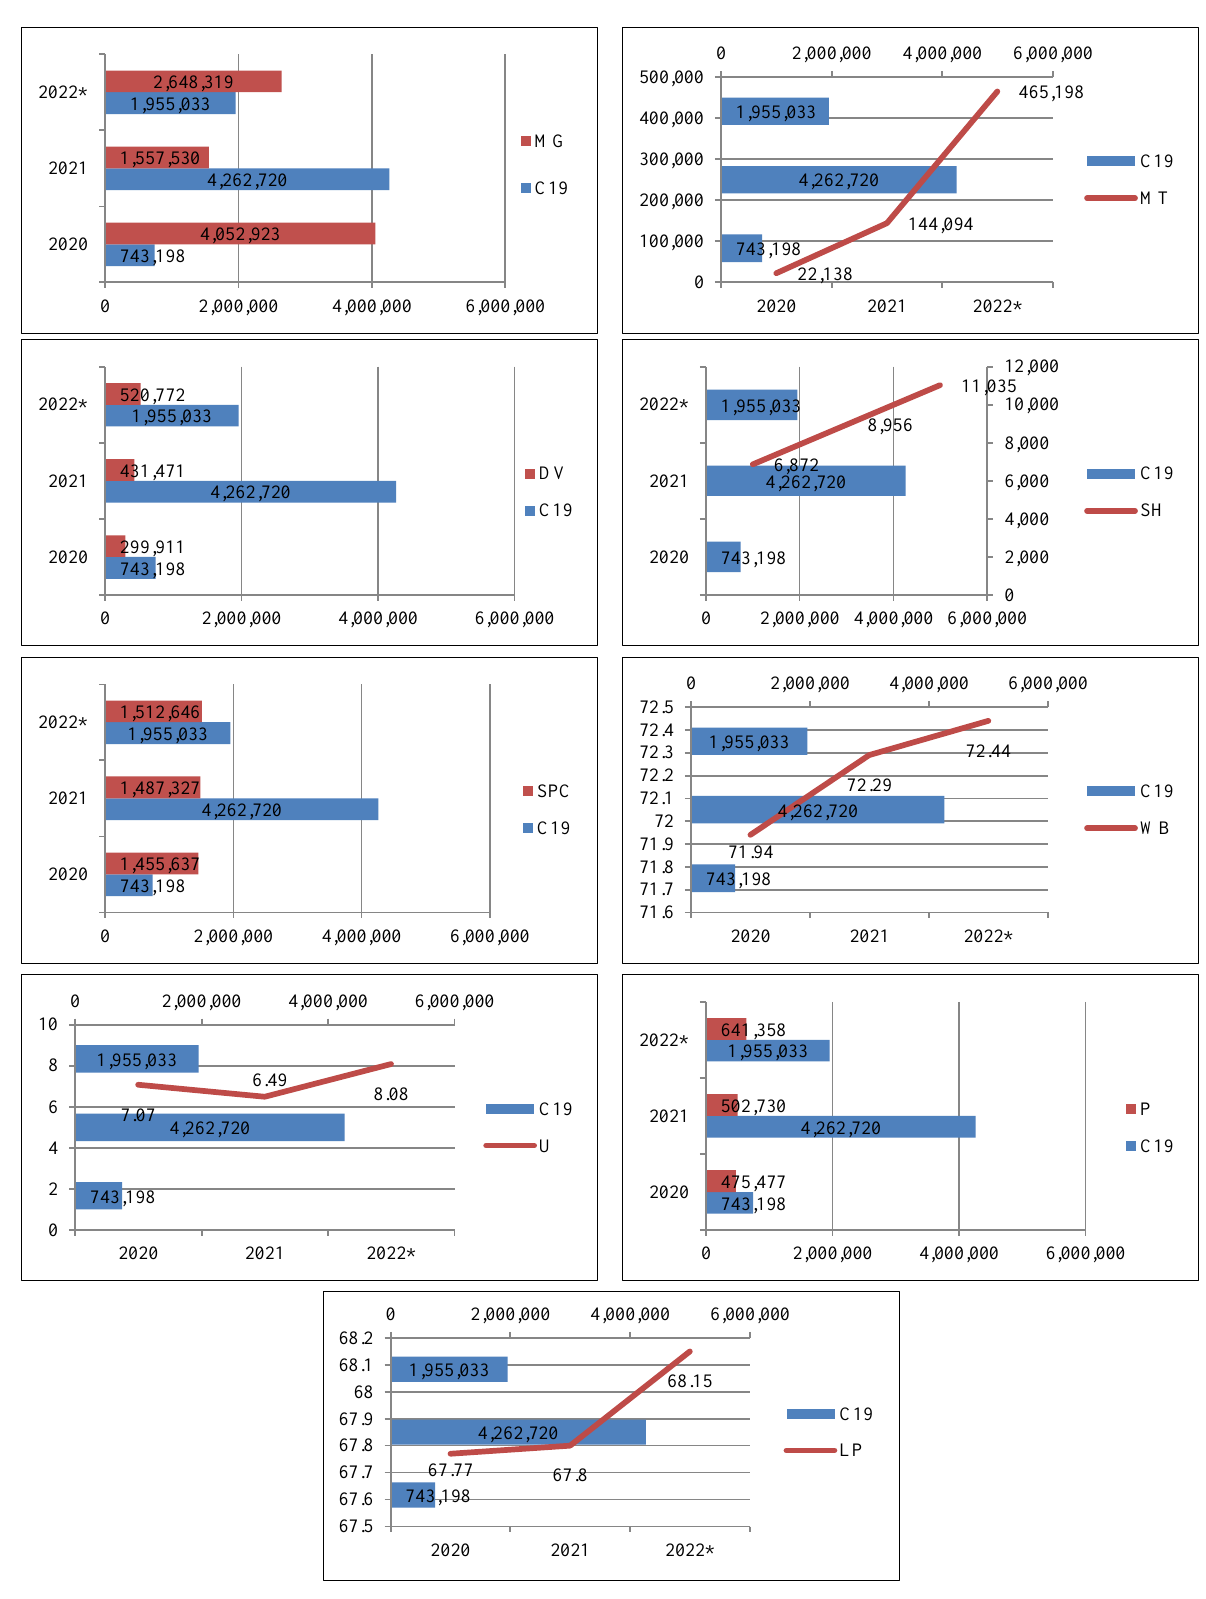
Figure 3. Interaction between variables